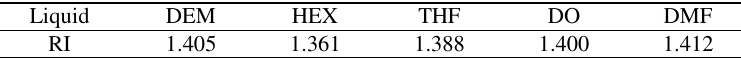
Table-1. Refractive index of pure liquids at 303.15K.